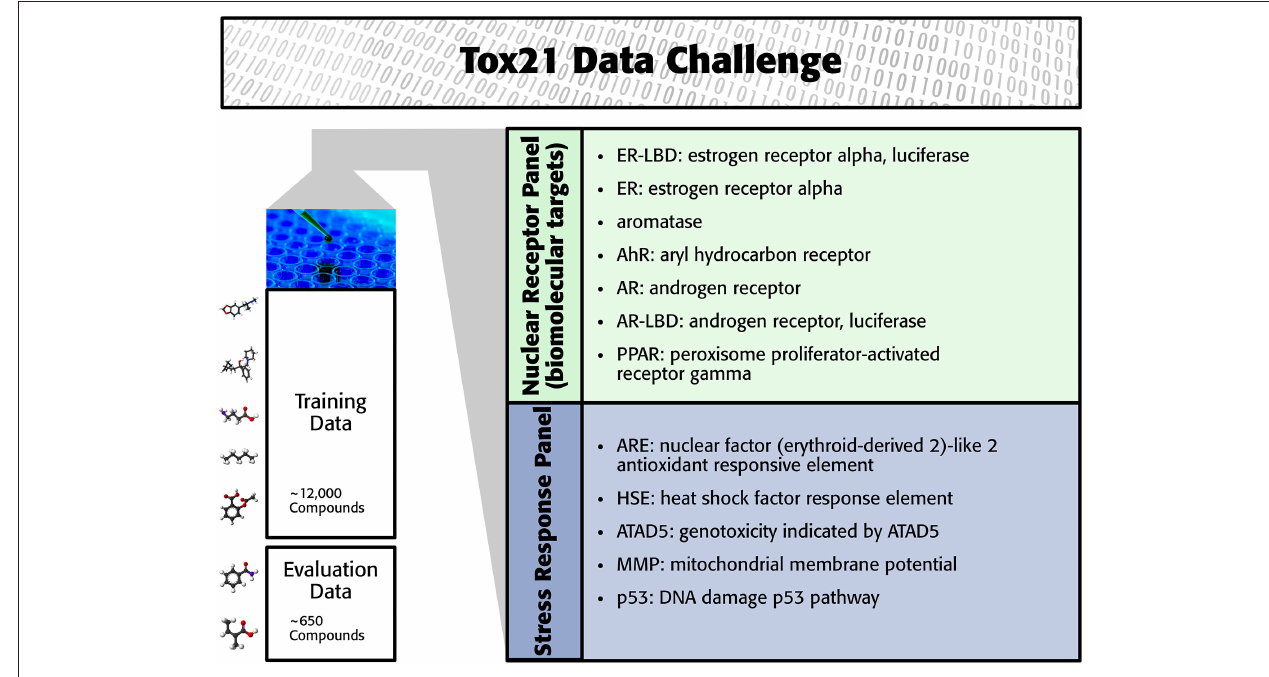
FIGURE 1 | Overview of the Tox21 challenge